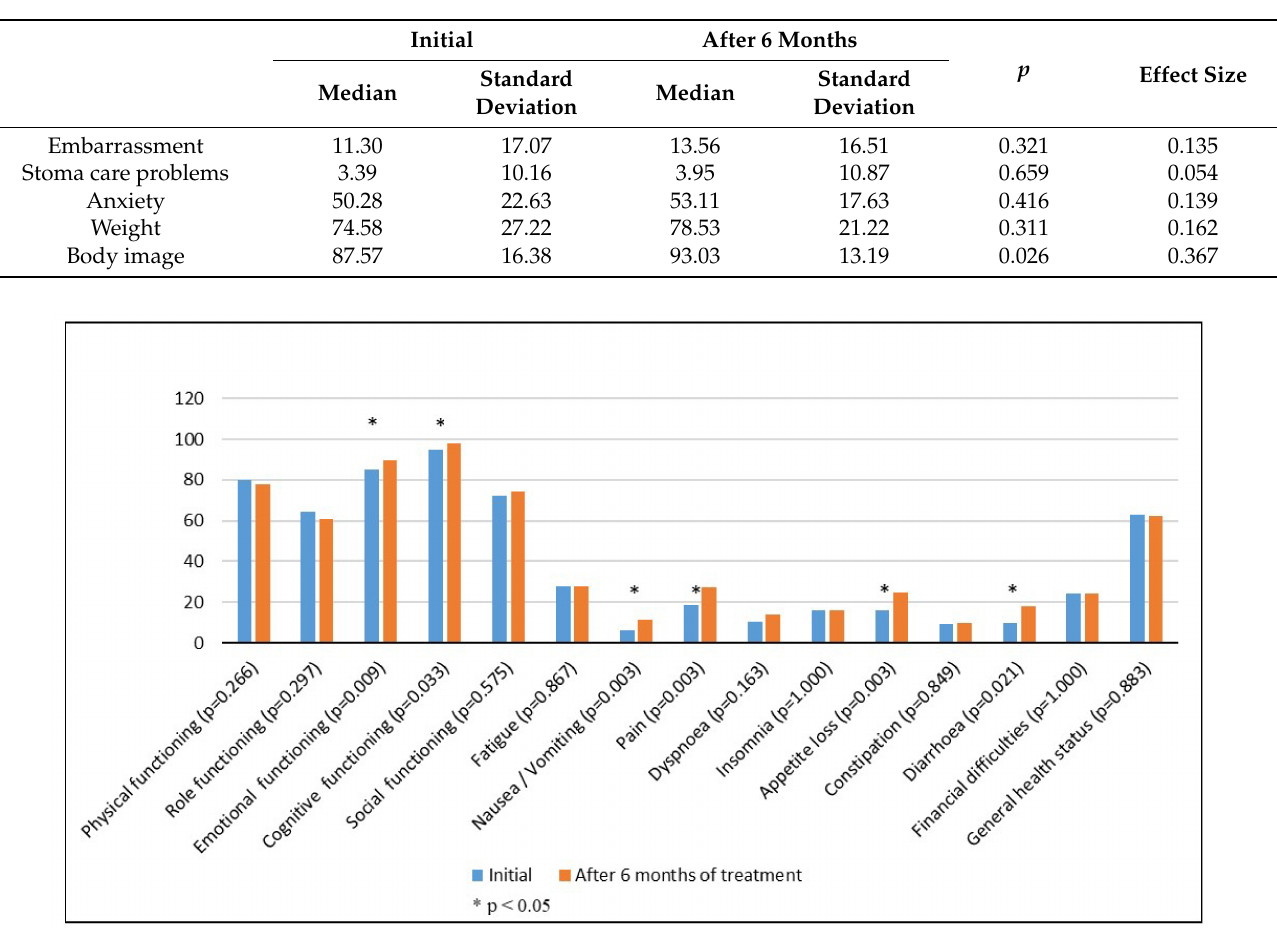
Figure 1. European Organization for Research and Treatment of Cancer QLQ-C30 questionnaire.